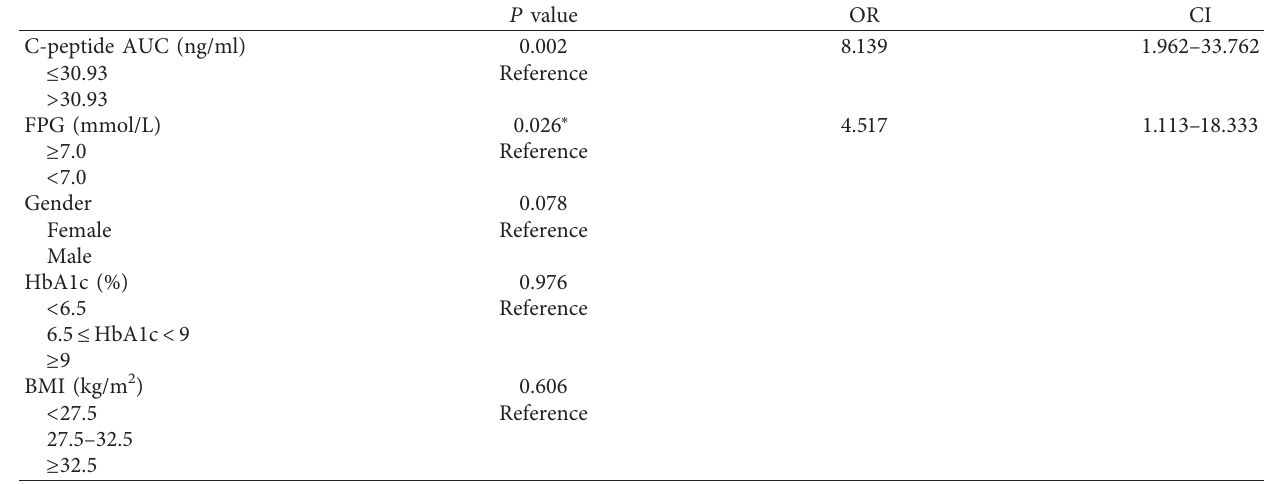
Table 5: Binary logistic regression of prolonged remission predictors.